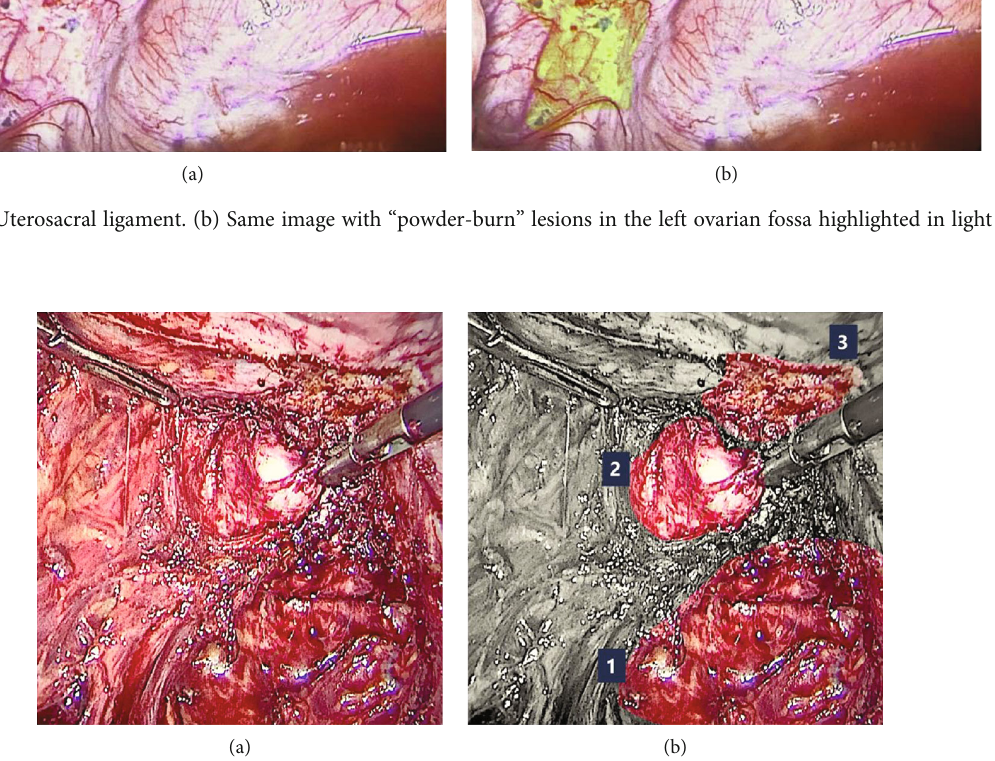
Figure 4: (a) Left paracolpium. (b) Same image identifying (1) left pararectal space, (2) tumor in the left paracolpium, and (3) insertion of the left uterosacral